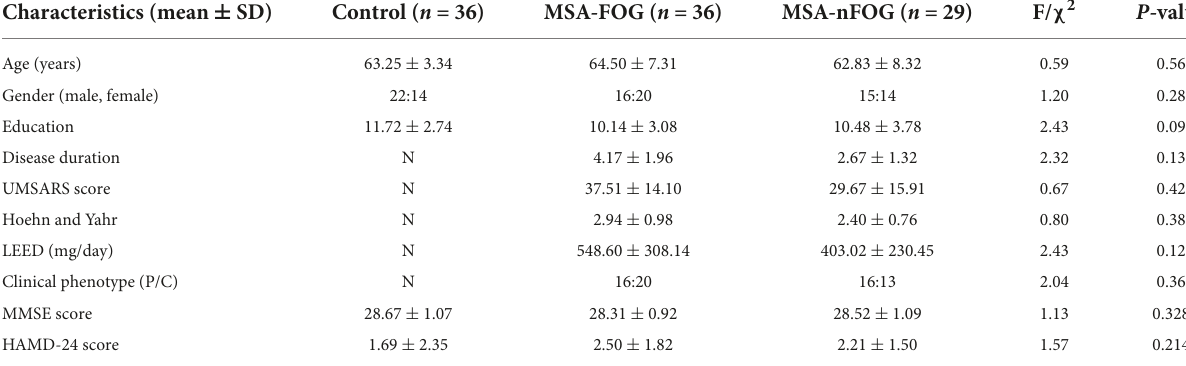
TABLE 1 Demographic and clinical